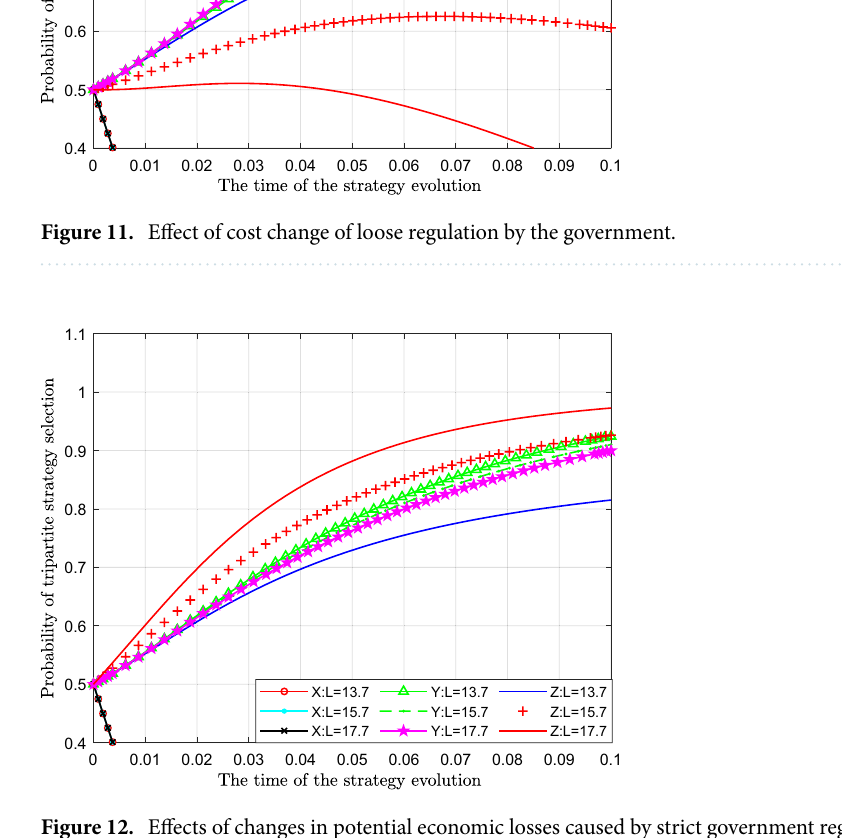
Figure 12. Effects of changes in potential economic losses caused by strict government